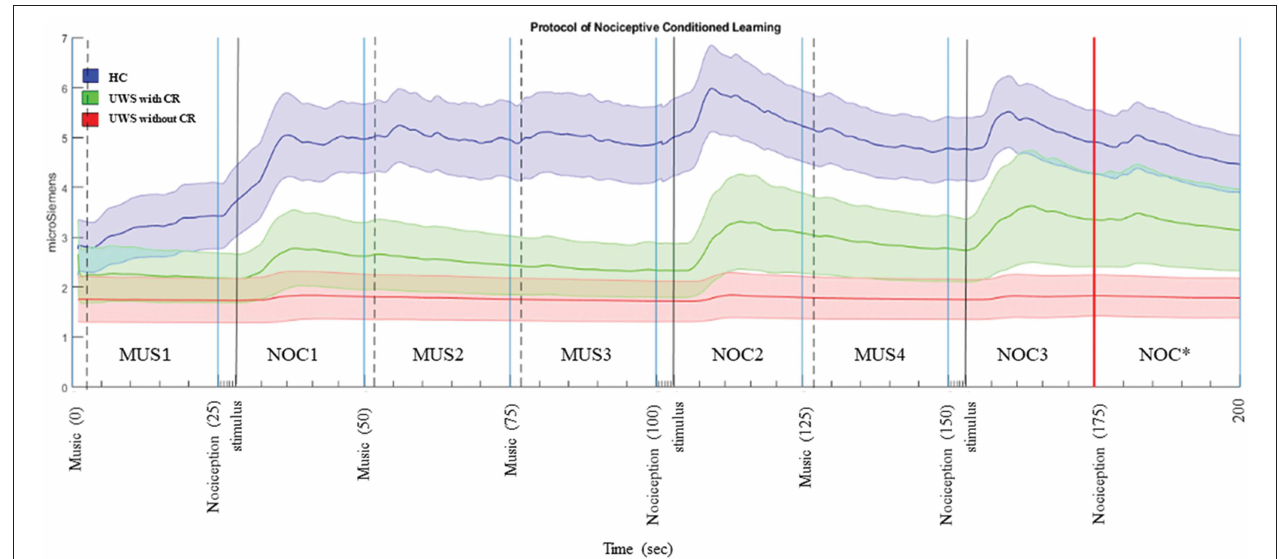
FIGURE 3 | Phasic components of GSR in the sequence A. The bold line is the mean of the GSR signal, and the filled area is the standard error. In blue the HC, green UWS patients with CR, and red UWS patients without CR. Vertical black continuous lines are the start of nociception stimulus, dashed black lines are the start of musical stimulus, vertical red line is the start of CR. MUS4, NOC3, and NOC* were considered in the statistical analysis to verify the conditional learning.